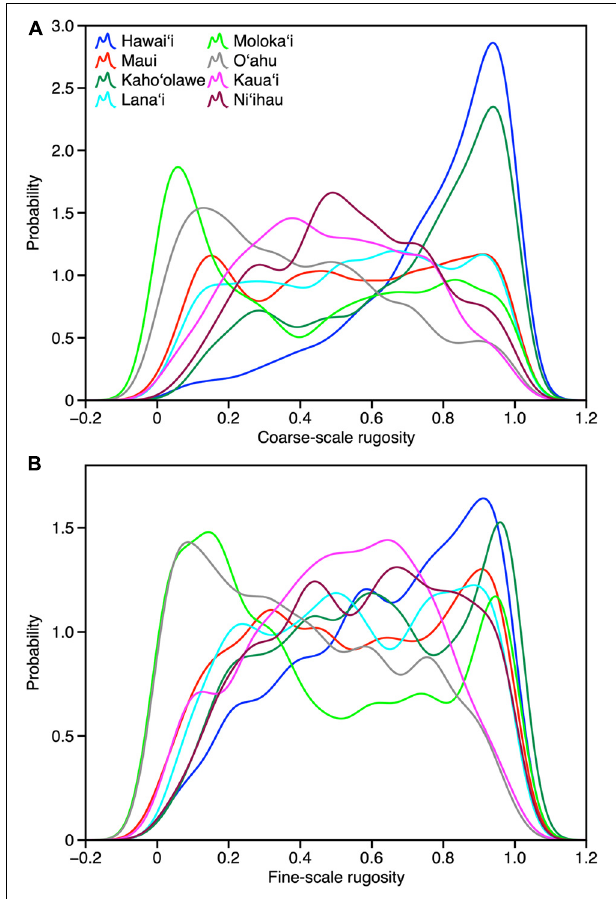
FIGURE 4 | Frequency distributions of (A) coarse-scale and (B) fine-scale rugosity by island.